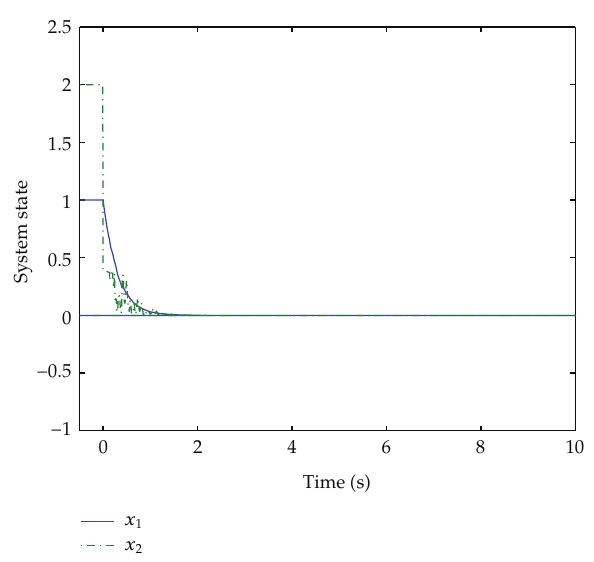
Figure 4: The state trajectories of the closed-loop system under SF control.